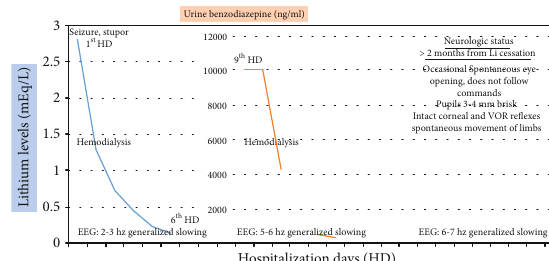
Figure 1: Timeline of the patient ’ s neurologic status and serum lithium and urine benzodiazepine levels. HD: hospitalization day; Li: lithium; EEG: electroencephalogram; hz: